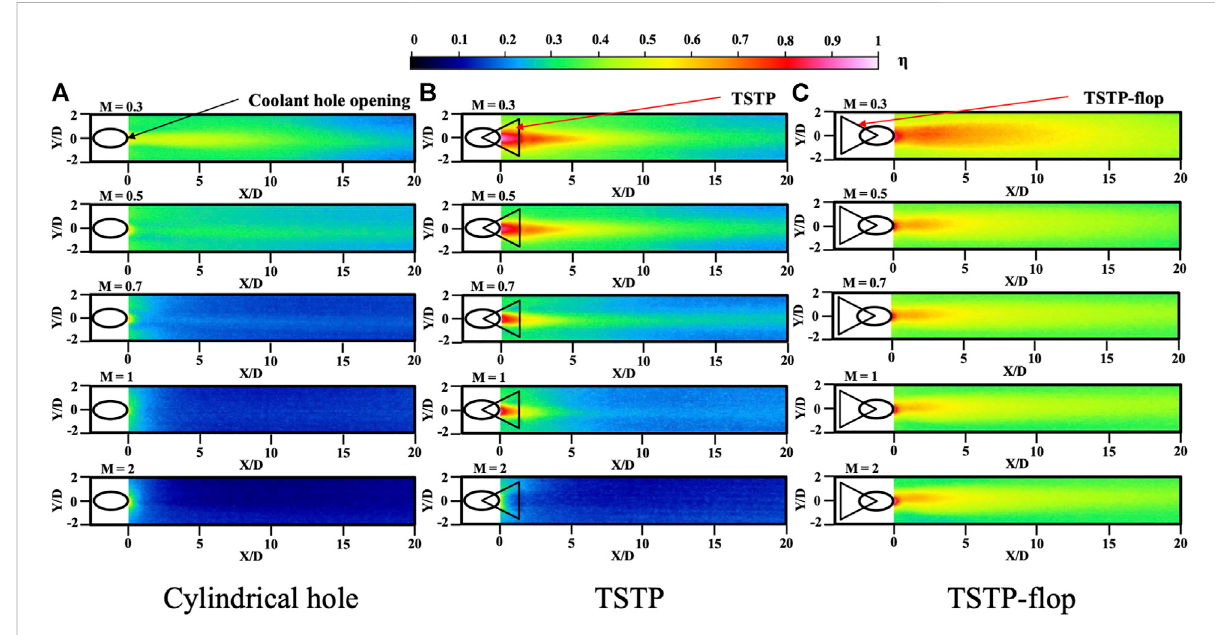
FIGURE 7 Film cooling effectiveness distribution evaluated by the temperatures of thermographic